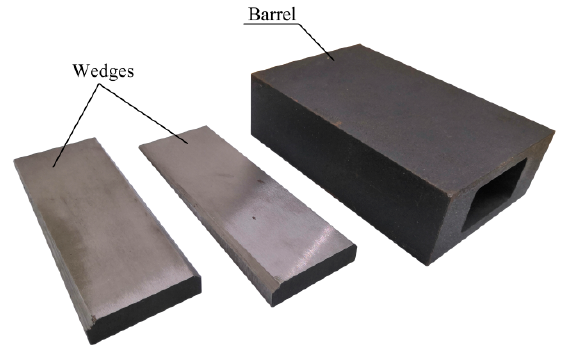
Figure 2. Parts of the friction ‐ based wedge anchor.